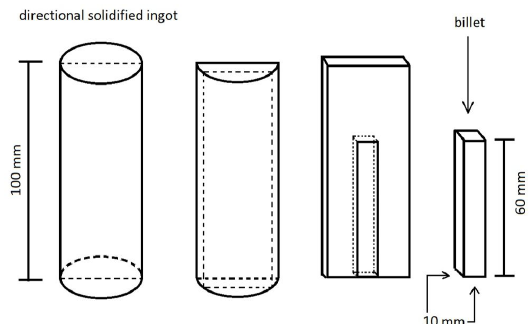
Figure 3. Schematic to illustrate the obtention of the billets from the solidified ingots.